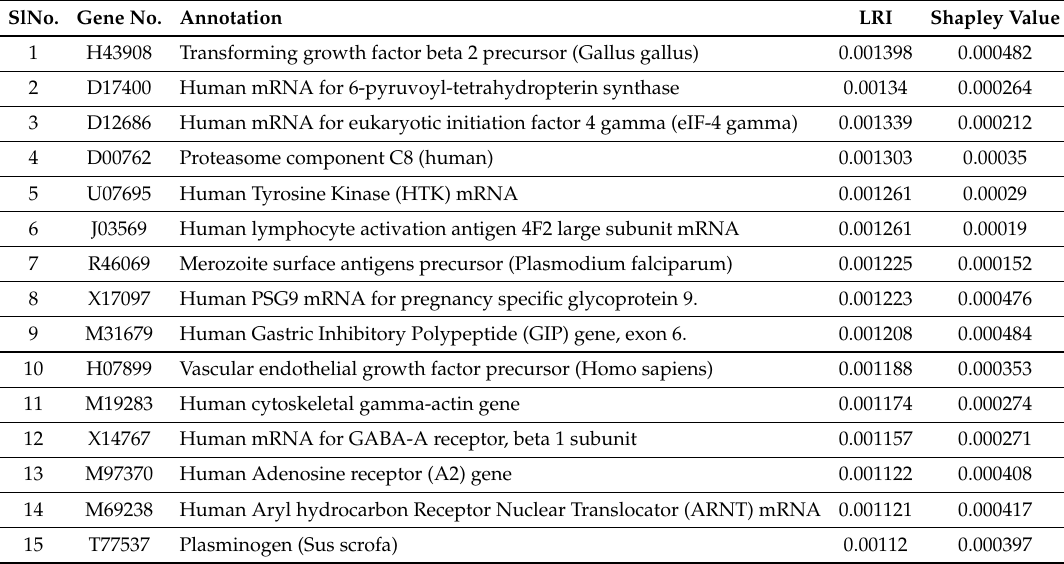
Table 1. Top 15 genes with highest LRI and its corresponding Shapley value.